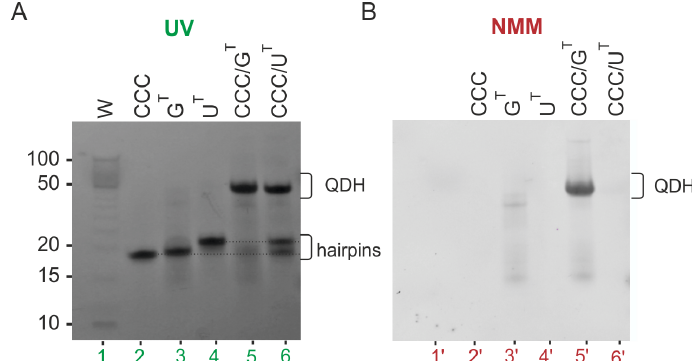
Figure 3. Analysis of the migration of CCC, G T , U T , CCC/G T , and CCC/U T by non-denaturing PAGE 20%; gel was visualized by UV light (254 nm) to detect all RNAs ( A ) and post-stained with NMM solution to detect G4 motifs ( B ).